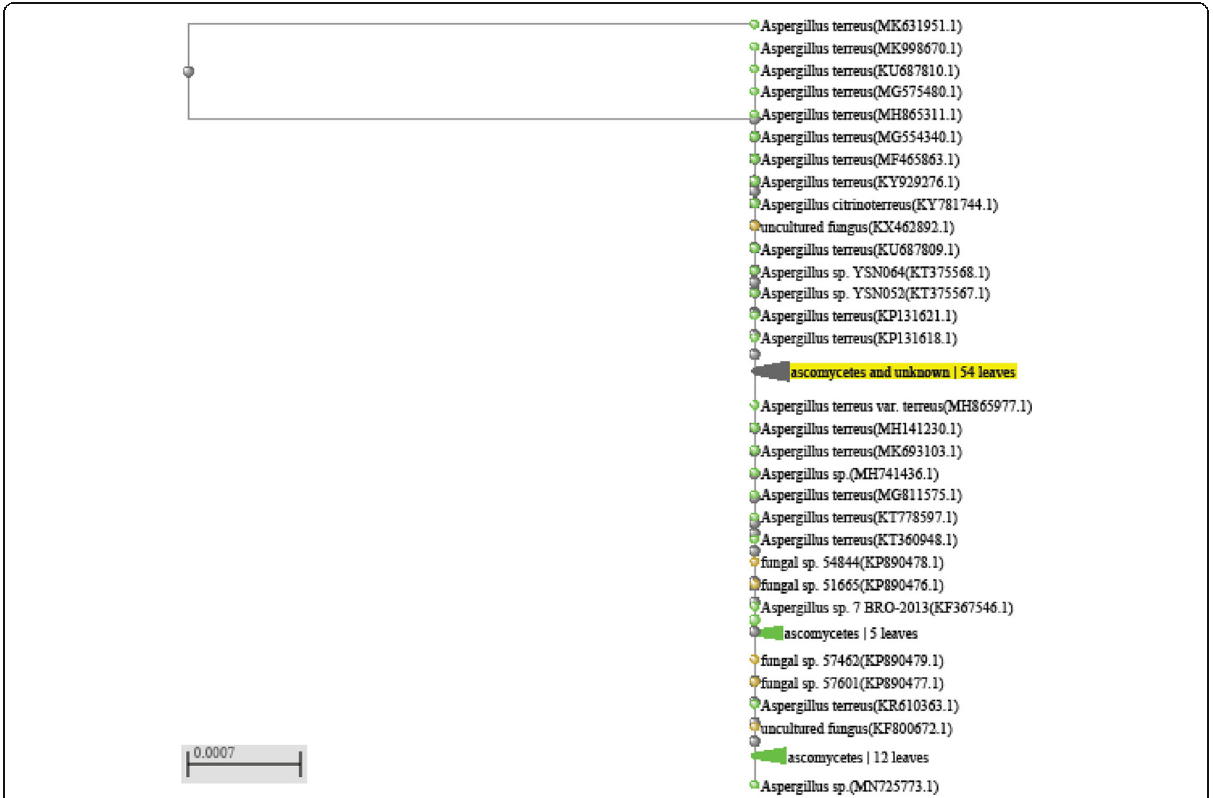
Fig. 1 Phylogenetic tree presenting the relations of Aspergillus terrus SS_RS-NE with other Aspergillus species